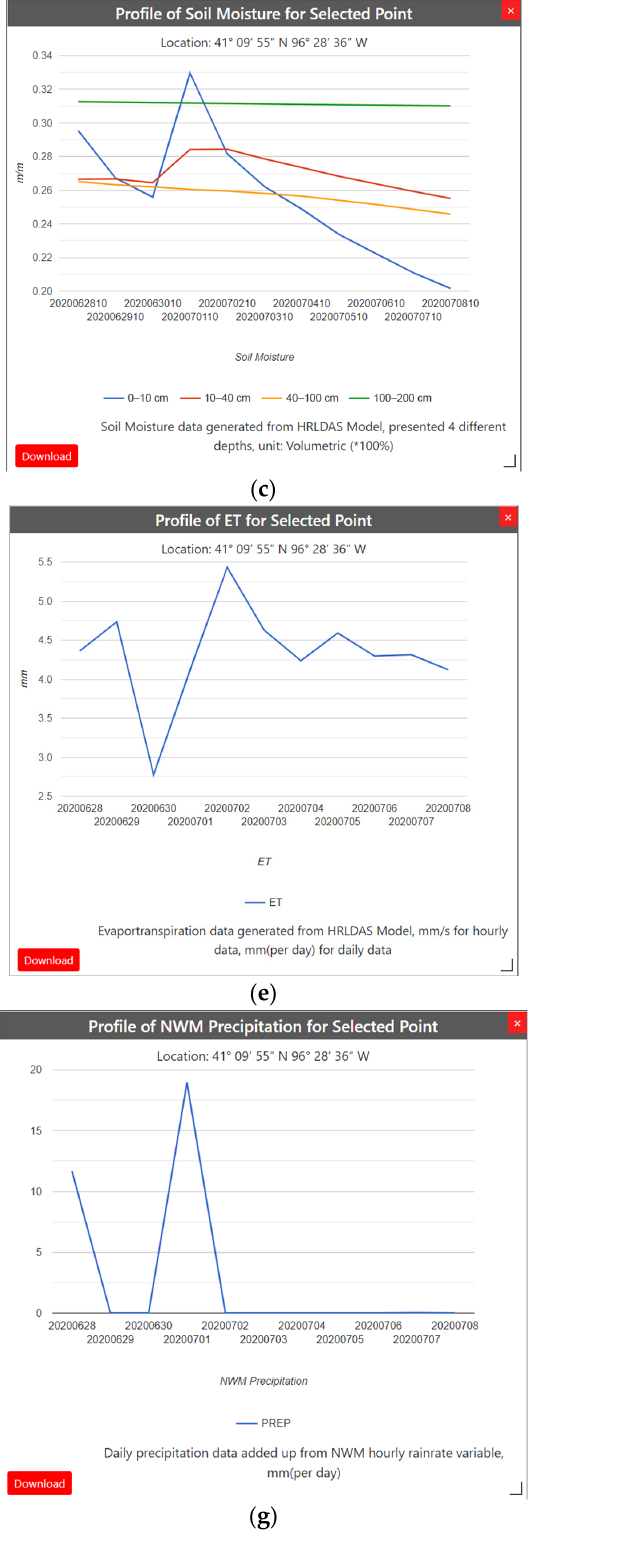
Figure 6. Information needed before irrigation decision making. ( a ) Soil properties; ( b ) Weather variables; ( c , d ) Recent and future soil moisture; ( e , f ) Recent and future ET; ( g , h ) Recent and future rain rate.